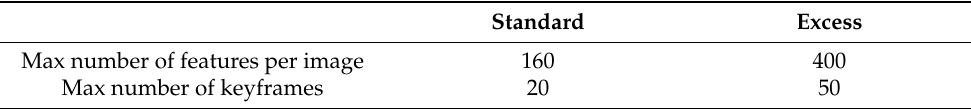
Table 5. Two different parameter settings of Struct-PL-SVO.